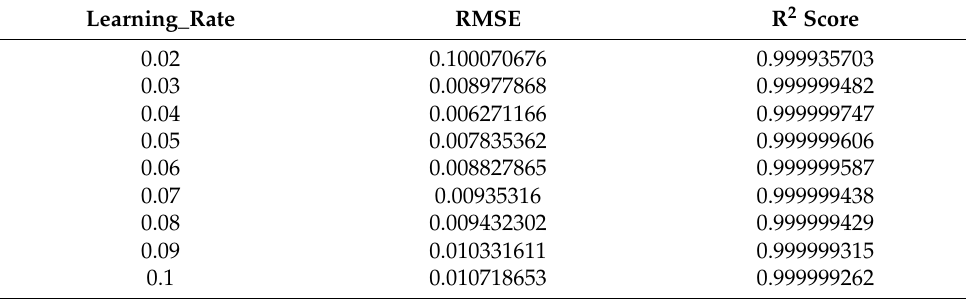
Table 3. learning_rate adjusts corresponding error and score.